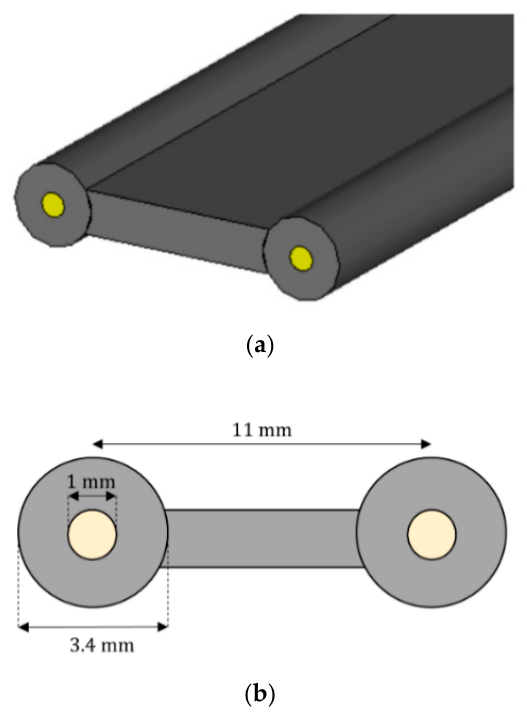
Figure 6. Sensing element perspective view ( a ) and cross section ( b ).